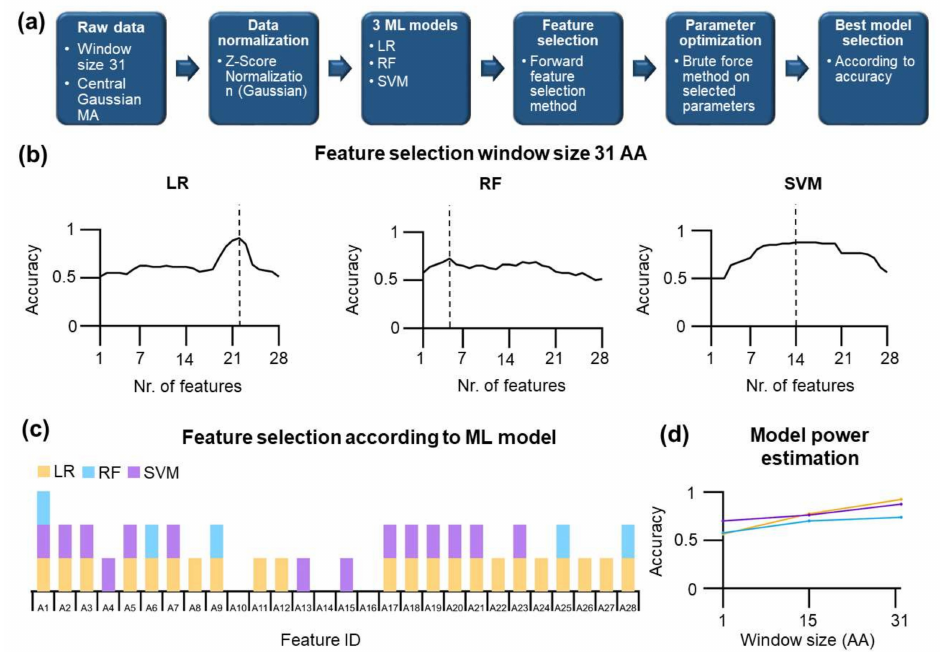
Figure 6. The application of supervised ML methods (random forest—RF, support vector machine— SVM, logistic regression—LR) to data at 31 aa window size. ( a ) Workflow for the ML methods. ( b ) The number of features, inputs for the learning, as a function of the accuracy for U/S prediction of three ML algorithms using the forward feature selection method. Based on the accuracy criterion, LR was the best ML method (0.913). Here, the methods are before the parameter optimization. ( c ) Selected features for the ML models were chosen based on their usage for the models with the highest accuracy. Only feature A1 was used in all three models. ( d ) Models accuracy after features selections and parameter optimizations at window sizes 1, 15, and 31 aa window size MA. The LR model showed the best accuracy